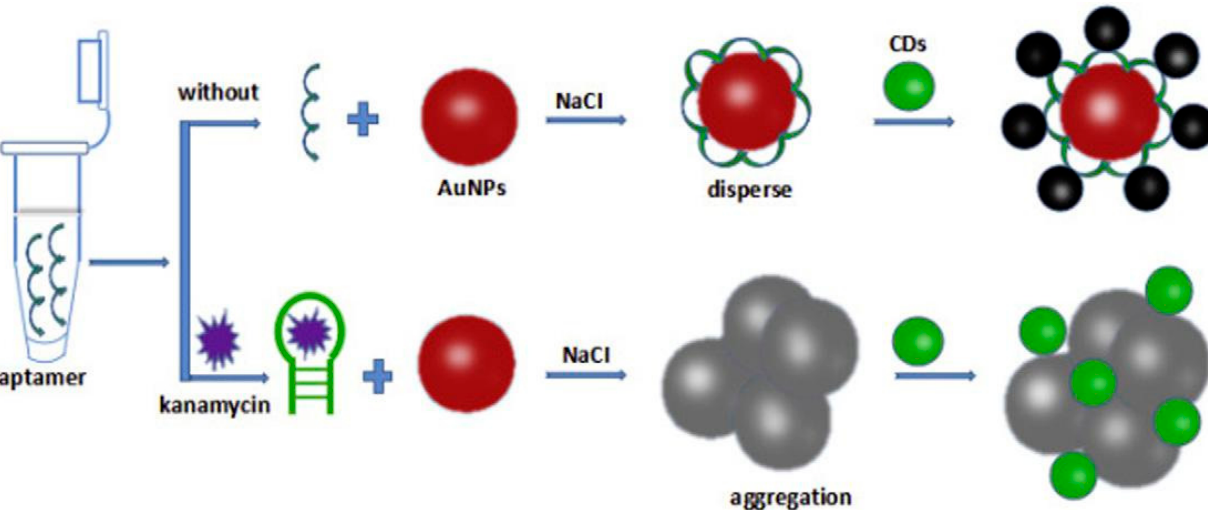
Figure 10. Optical aptasensor for kanamycin detection in milk. Monodispersed AuNPs coated with kanamcin-specific aptamers undergo aggregation upon displacing of the aptamers by the kanamycin molecules leading to changes in the fluorescence yield of quantum CDs. Image adapted from [84] with permission of Elsevier, 2020.